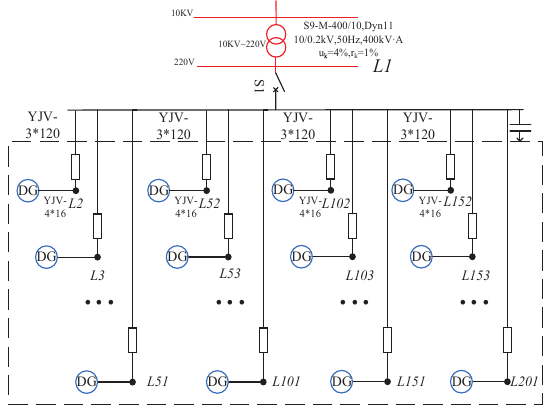
Figure 2. Star topology electrical